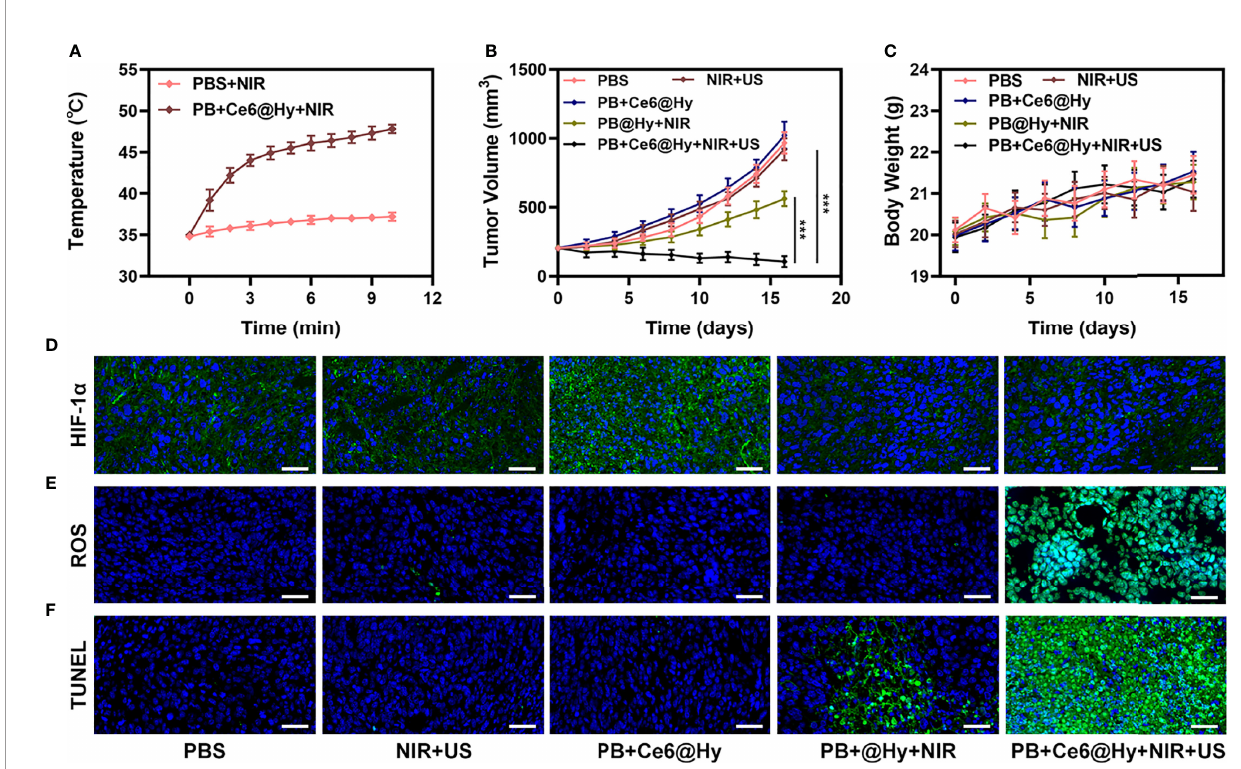
FIGURE 3 | Results of in vivo experiments. (A) Temperature increases in mice implanted with 4T1 tumors following 808 nm laser irradiation (0.5 W/cm 2 ) for 10 min in the indicated treatment groups. (B) Tumor volume change over time in groups treated as indicated. (C) Time-dependent body-weight curves of mice in different